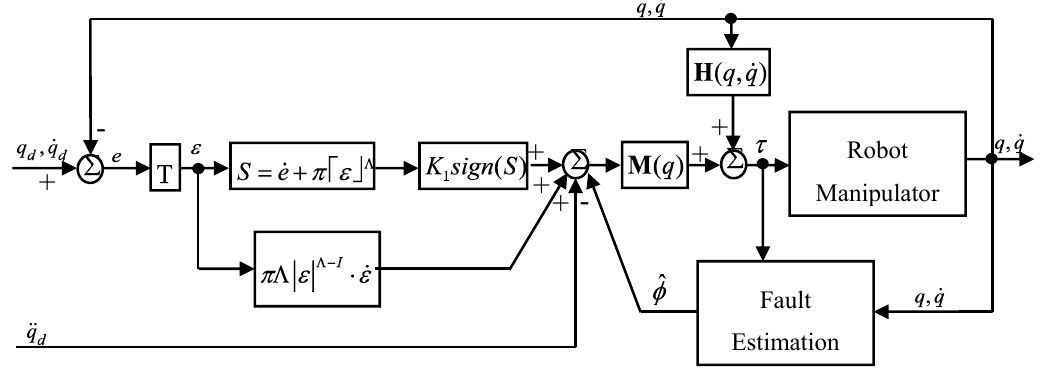
Figure 2. The block diagram of the proposed controller active fault-tolerant control with synchronous terminal sliding mode control 1 (AFTC-S-TSMC2).